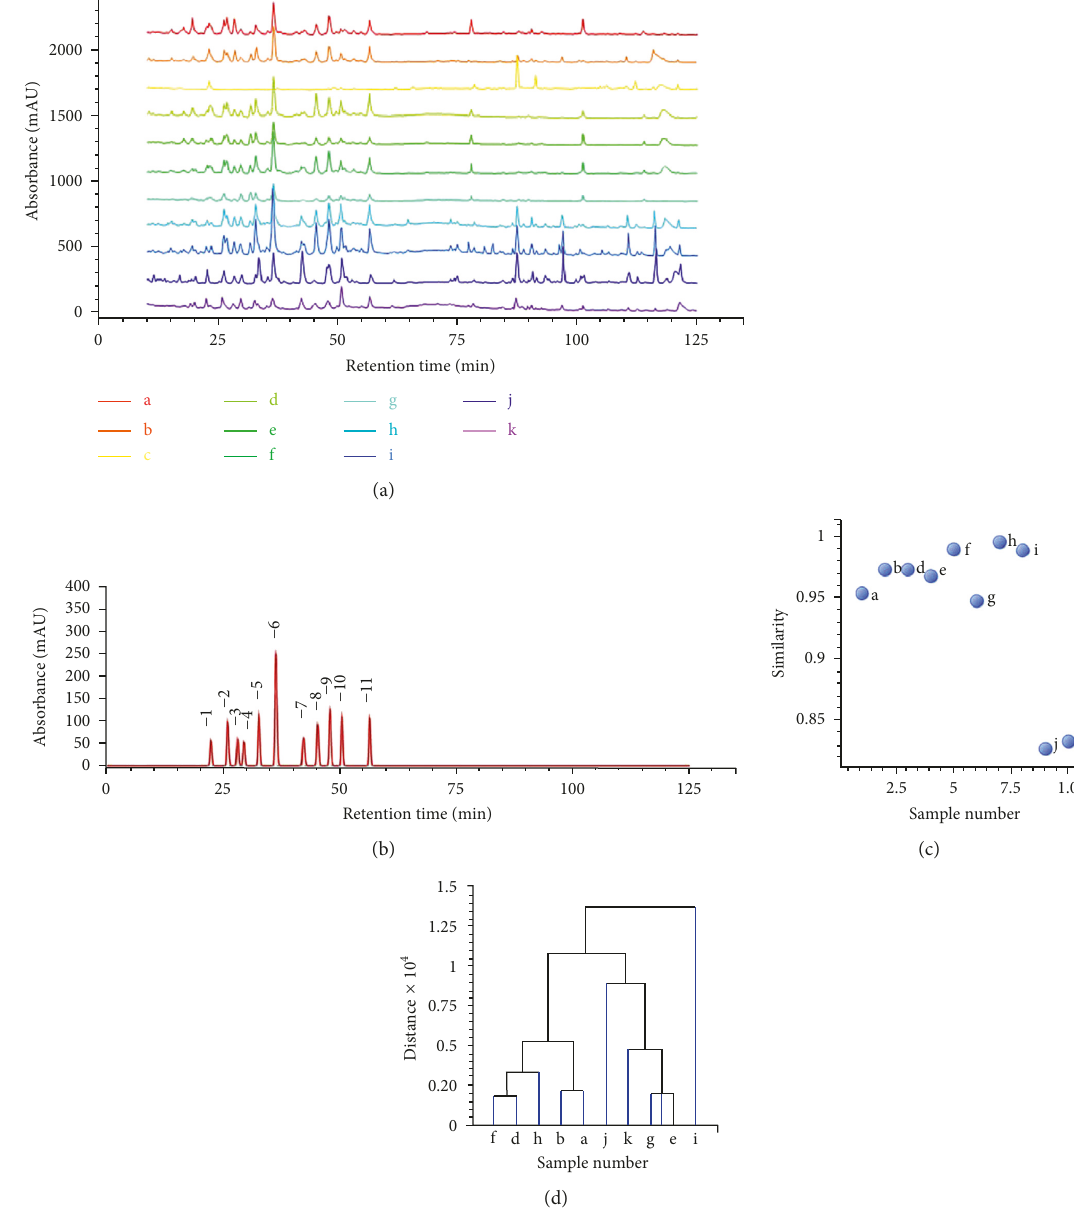
Figure 5: HPLC fingerprints of triterpenoids obtained from eleven batches of samples (a) and the common pattern generated by ChemPattern software (b). The similarity analysis (c) and clustering analysis (d) of